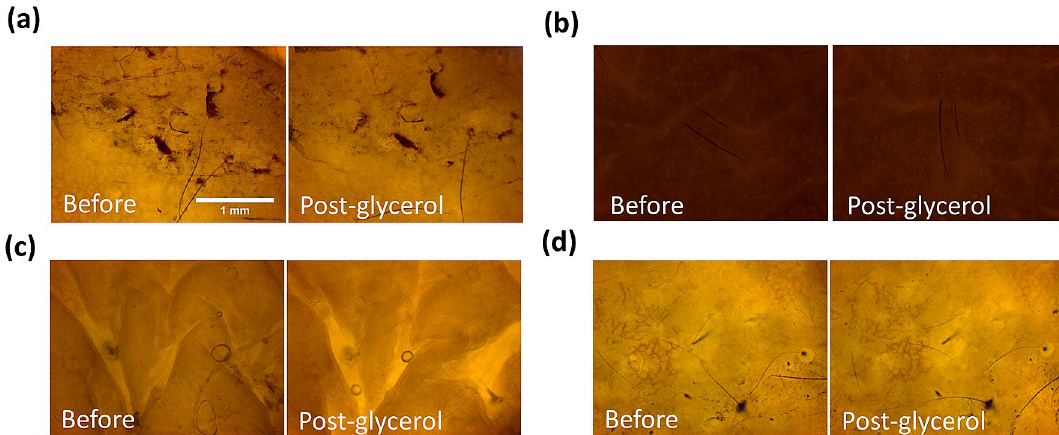
Figure 8. Bright field images of human skin before (Before) and after (Post-glycerol) 50% glycerol topical application. ( a ) Case E50-T90-1 ( b ) Case E50-T90-2 ( c ) Case E50-T90-3 ( d ) Case E50-T90-4. Scale bar = 1